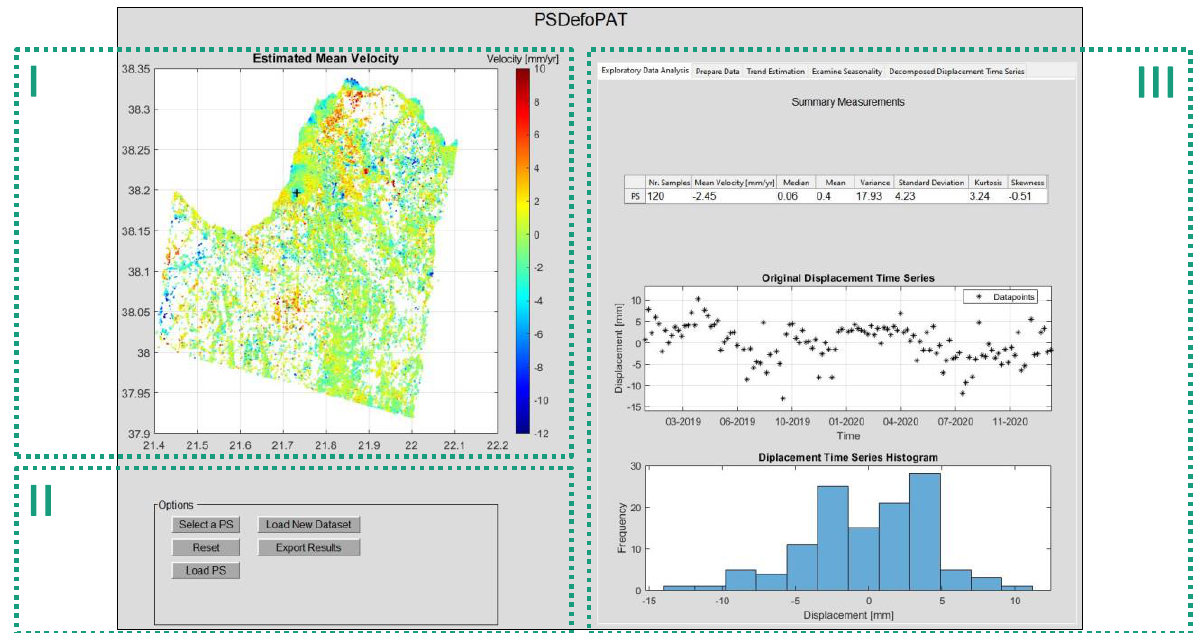
Figure 3 . The user interface of PSDefoPAT is structured into Areas I, II, and III.